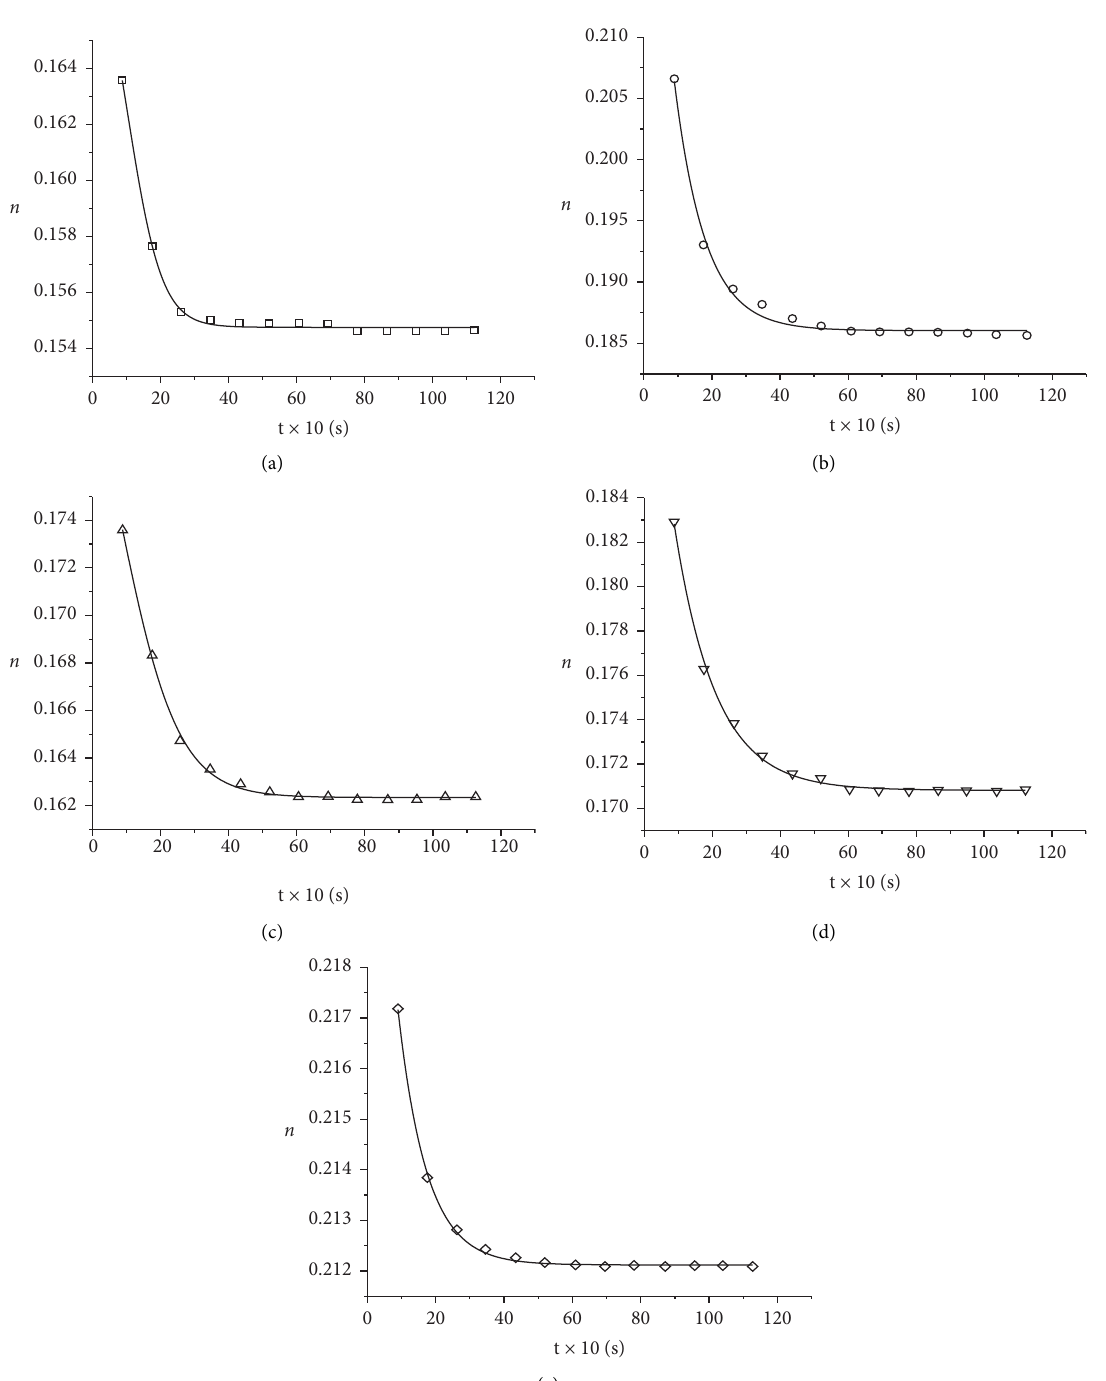
Figure 2: Relation curves between porosity of fragmentized coals and time under the stress of 8 MPa. (a) m1. (b) m2. (c) m3. (d) m4. (e)